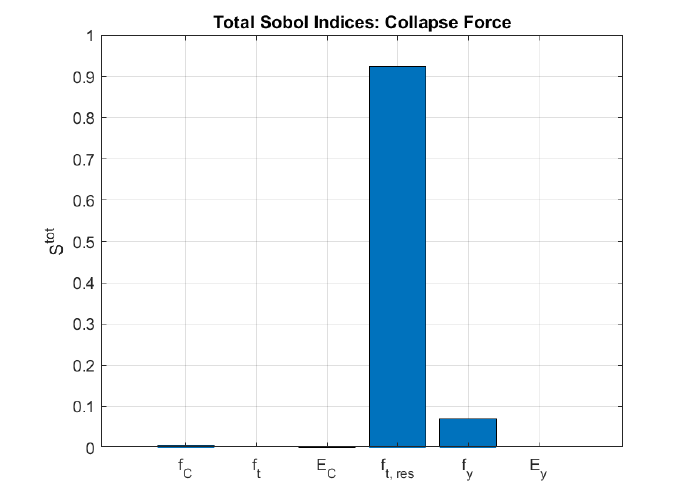
Figure 19. Total Sobol’ indices for collapse force.